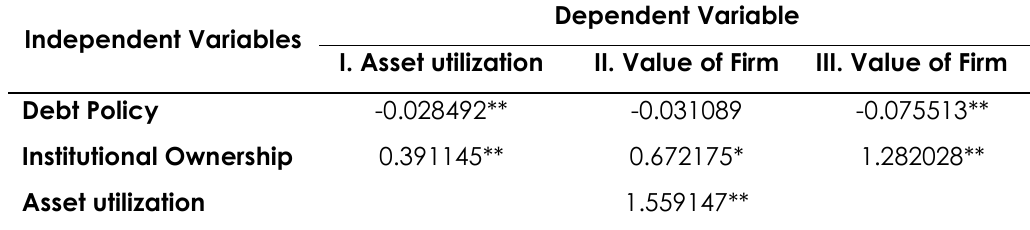
Table 1. Coefficient and Regression Significance